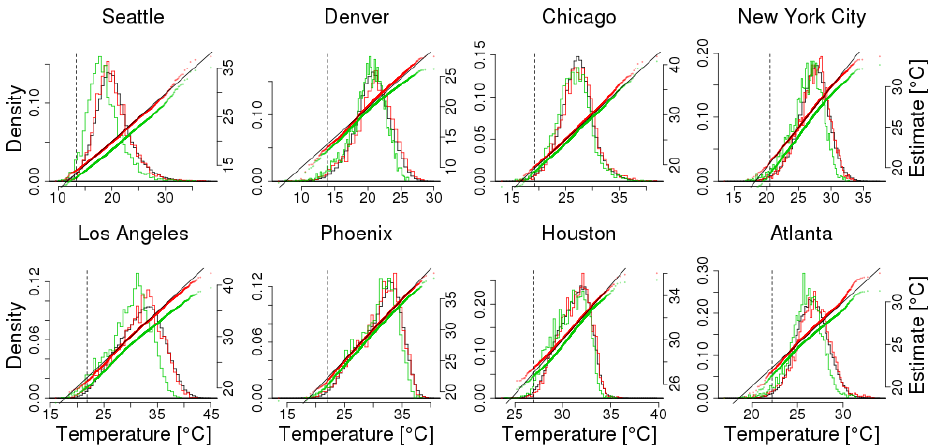
Figure A2. Same as Fig. 10 but for the summer months June, July, and August (JJA).